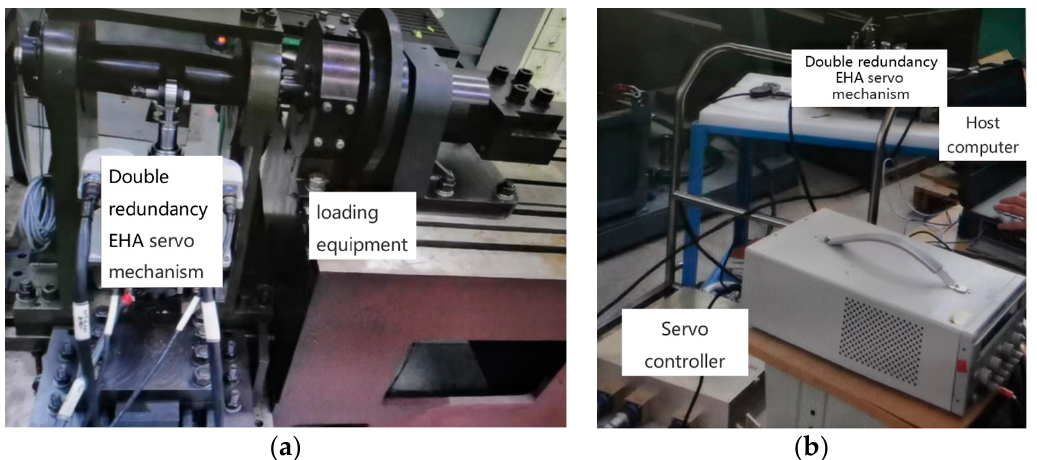
Figure 15. Testbench used for the fault injection experiments. ( a ) Load table test site; ( b ) Software and hardware debugging site.